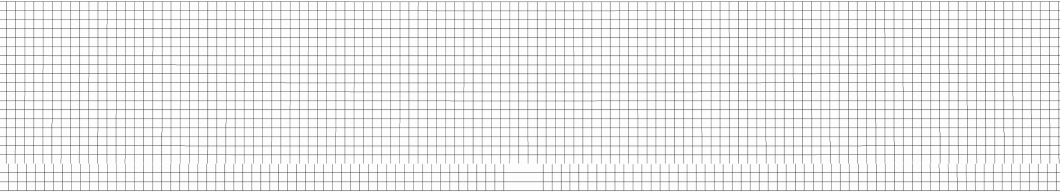
Figure 5. Deformed shape of the unidirectional specimen.